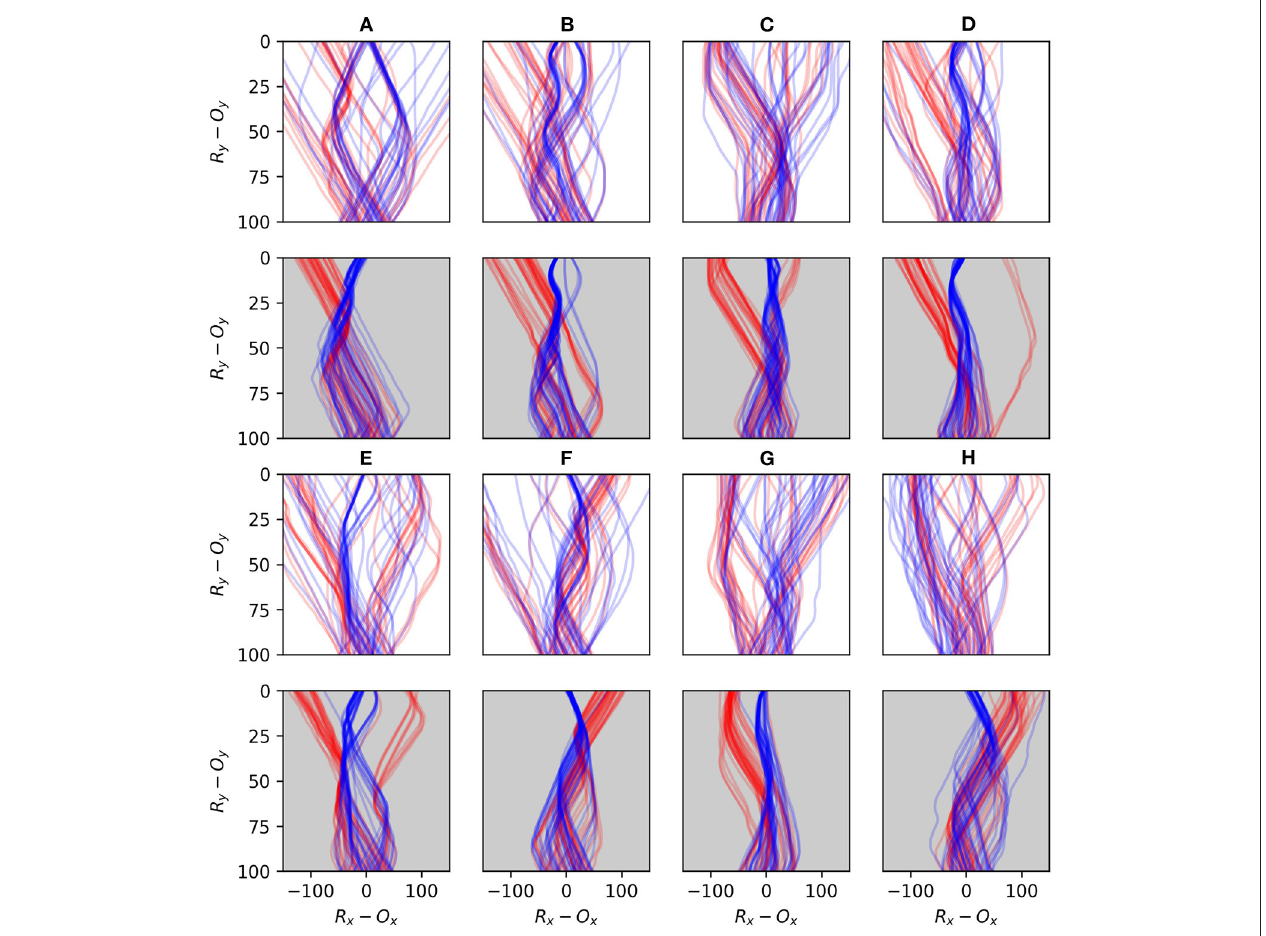
FIGURE 15 | Plots comparing the early and late stages of development for eight randomly selected runs. The first and third rows illustrate the first 40 interactions with each shape type for 8 different robots (A–H) , and the second and fourth rows show the last 40 interactions for the same robots. Blue lines indicate interactions with circles and red lines interactions with